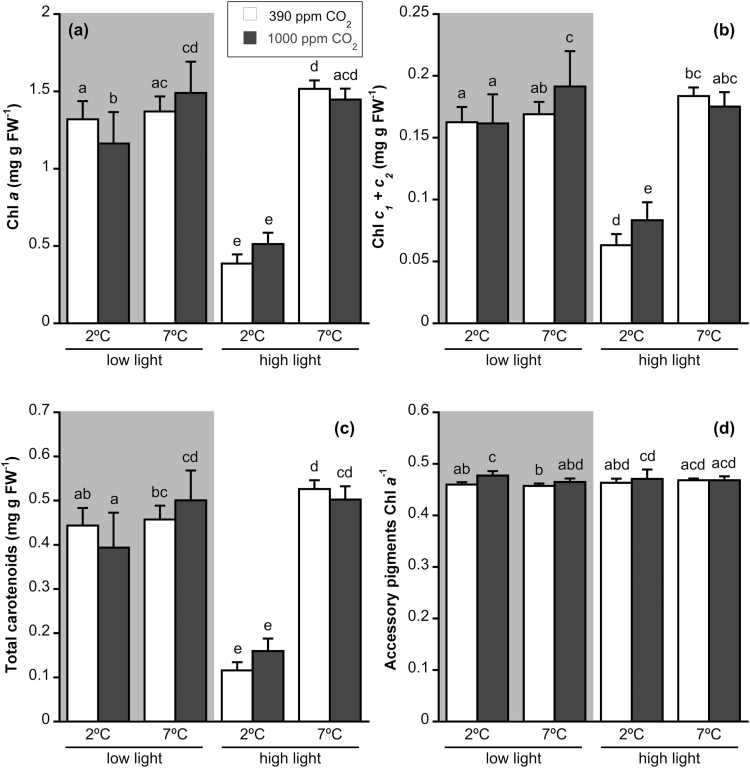
(a) Chl a content, (b) Chl c content, (c) relative total carotenoid content, and (d) accessory pigments Chl a−1 of Desmarestia anceps after 12 days of culture at different CO2 levels (380 or 1000 ppm), temperatures (2 or 7 °C), and irradiance conditions (65 μmol photons m−2 s−1 or 145 μmol photons m−2 s−1). Values are mean±SD (n=6). Significant differences (P<0.05) revealed by Fisher’s LSD test following a three-way ANOVA (CO2, temperature, and light) are indicated by different letters.